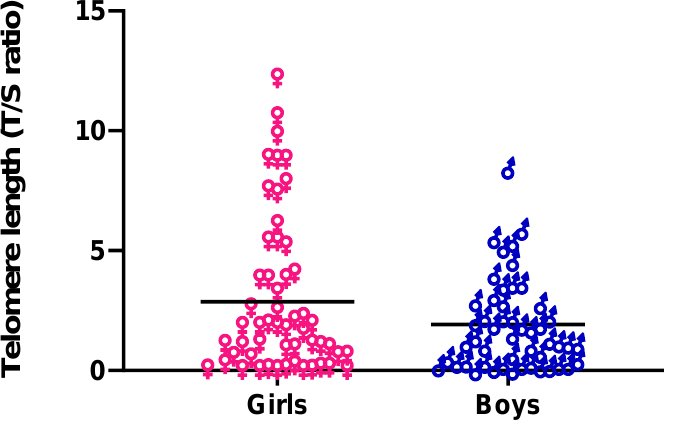
Figure 3. Telomere length (TL) comparison between newborn girls and boys. Girls have longer TL than boys.